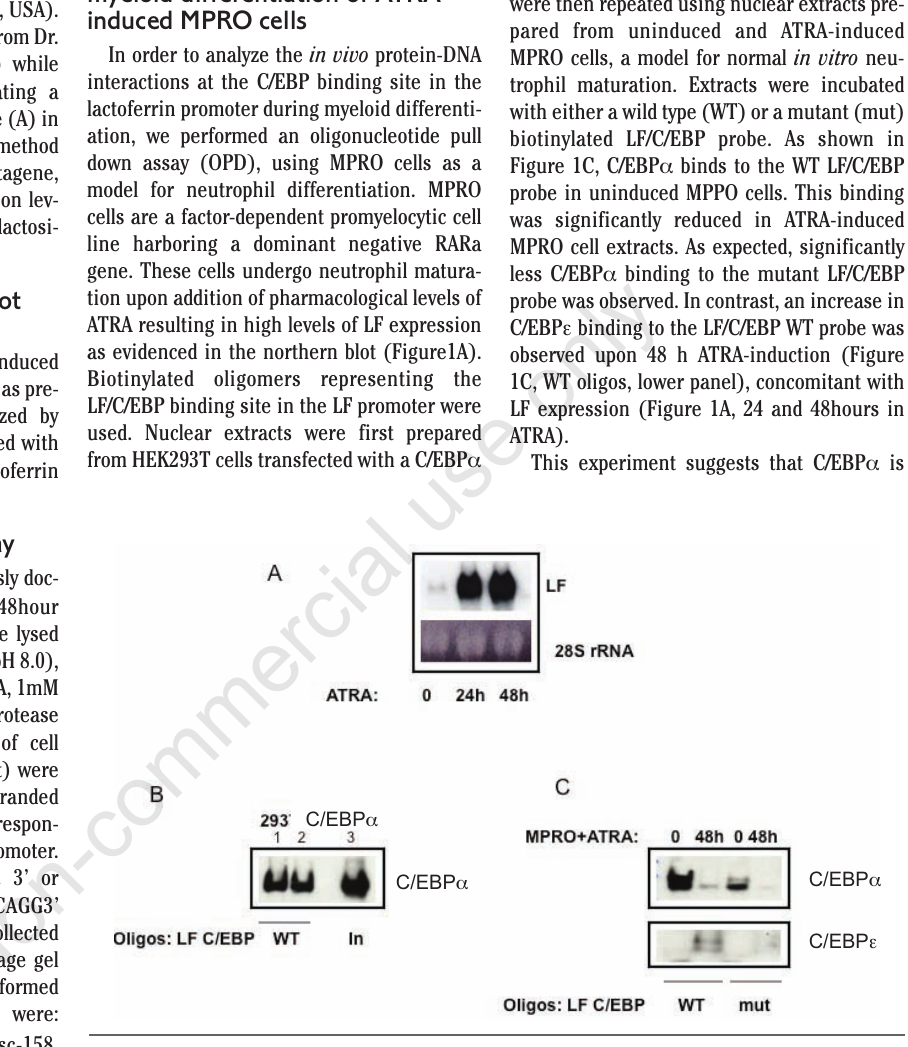
Figure 1. Binding of C/EBP a to the Lactoferrin (LF) promoter and expression of the LF gene during neutrophil maturation in ATRA-induced MPRO cells. A. Northern